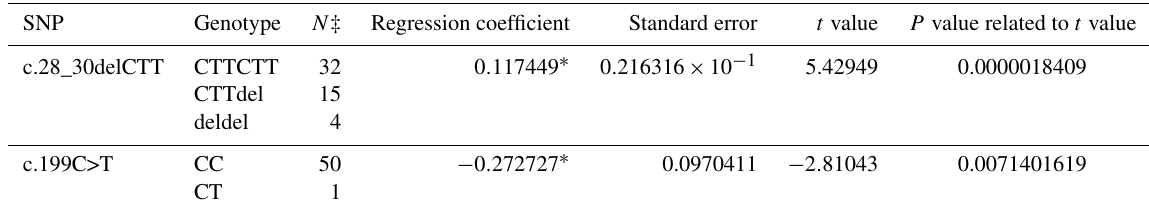
Table 4. The SNPs located in the first exon and intron in the BMP15 gene of the Ramlıç breed, with their significance levels and calculated regression